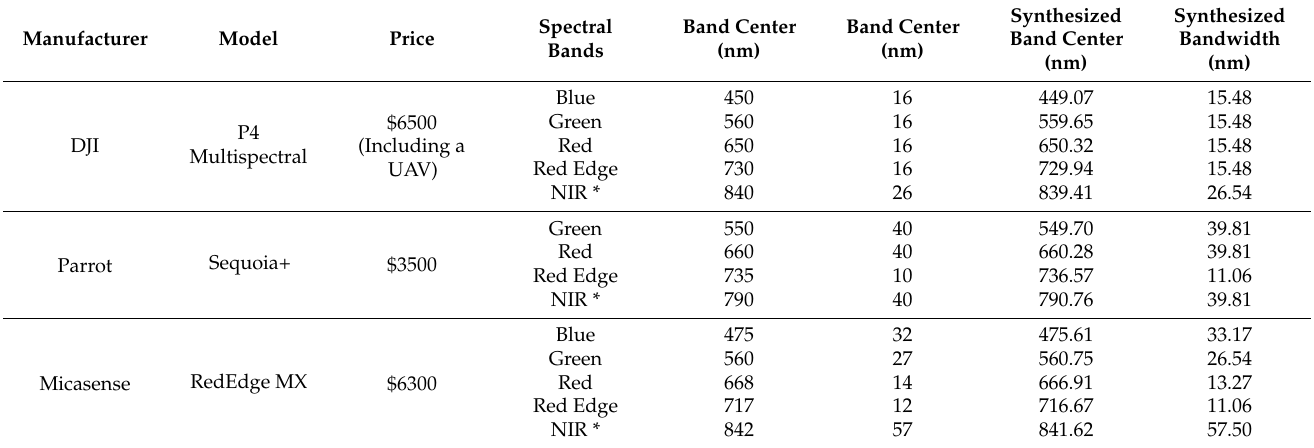
Table 2. True and synthesized spectral information of three widely used multispectral